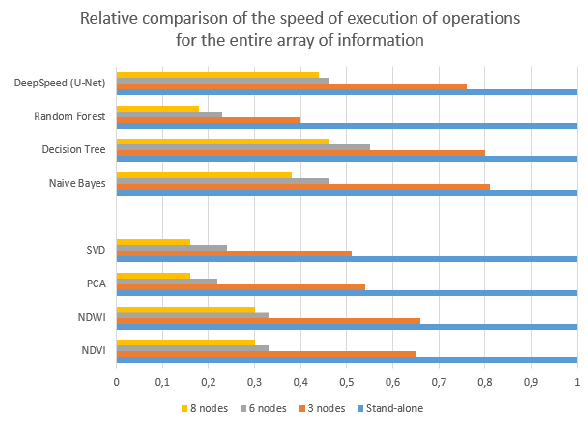
Figure 5 . Diagram of relative comparison of the speed of execution of operations for the entire array of